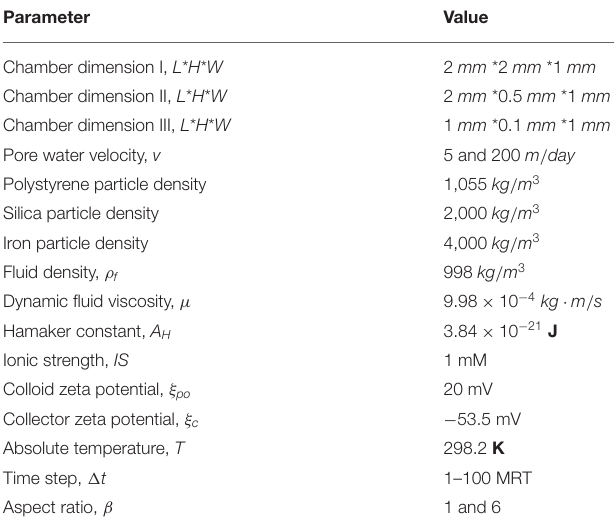
TABLE 1 | Parameters used in lagrangian trajectory